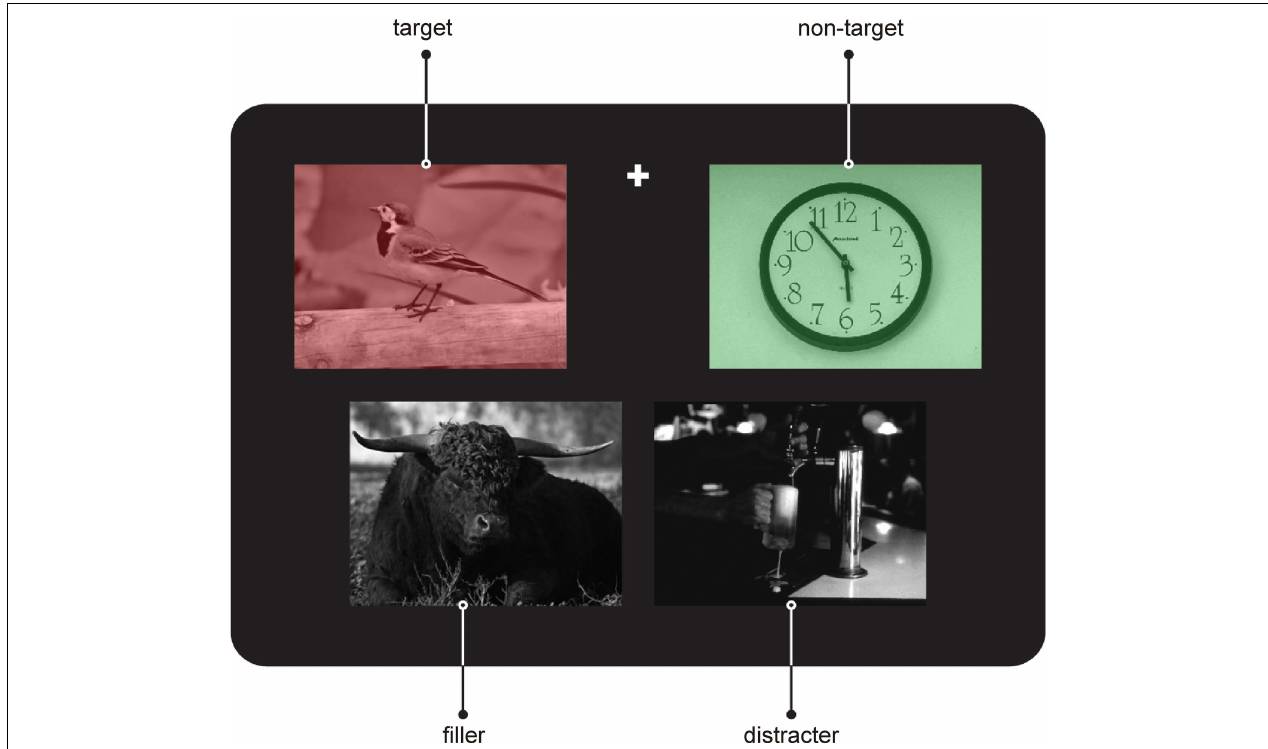
cross during the entire run. Importantly, gray distracter pictures, always presented contralaterally to the target picture, could be either neutral but showed always the contrary condition to the target picture (e.g., target “living, distracter “non-living”, 50%) or contain alcohol-related cues (50%, taken from Heinz et al., 2004). Patients participated in two experimental runs comprising 448 trials. The stimulus duration was 1000 ms, and the interstimulus-interval was jittered between 2200 and 2500 ms. Identical sets of stimuli were presented in randomized order in both runs. Only the instruction regarding the target color